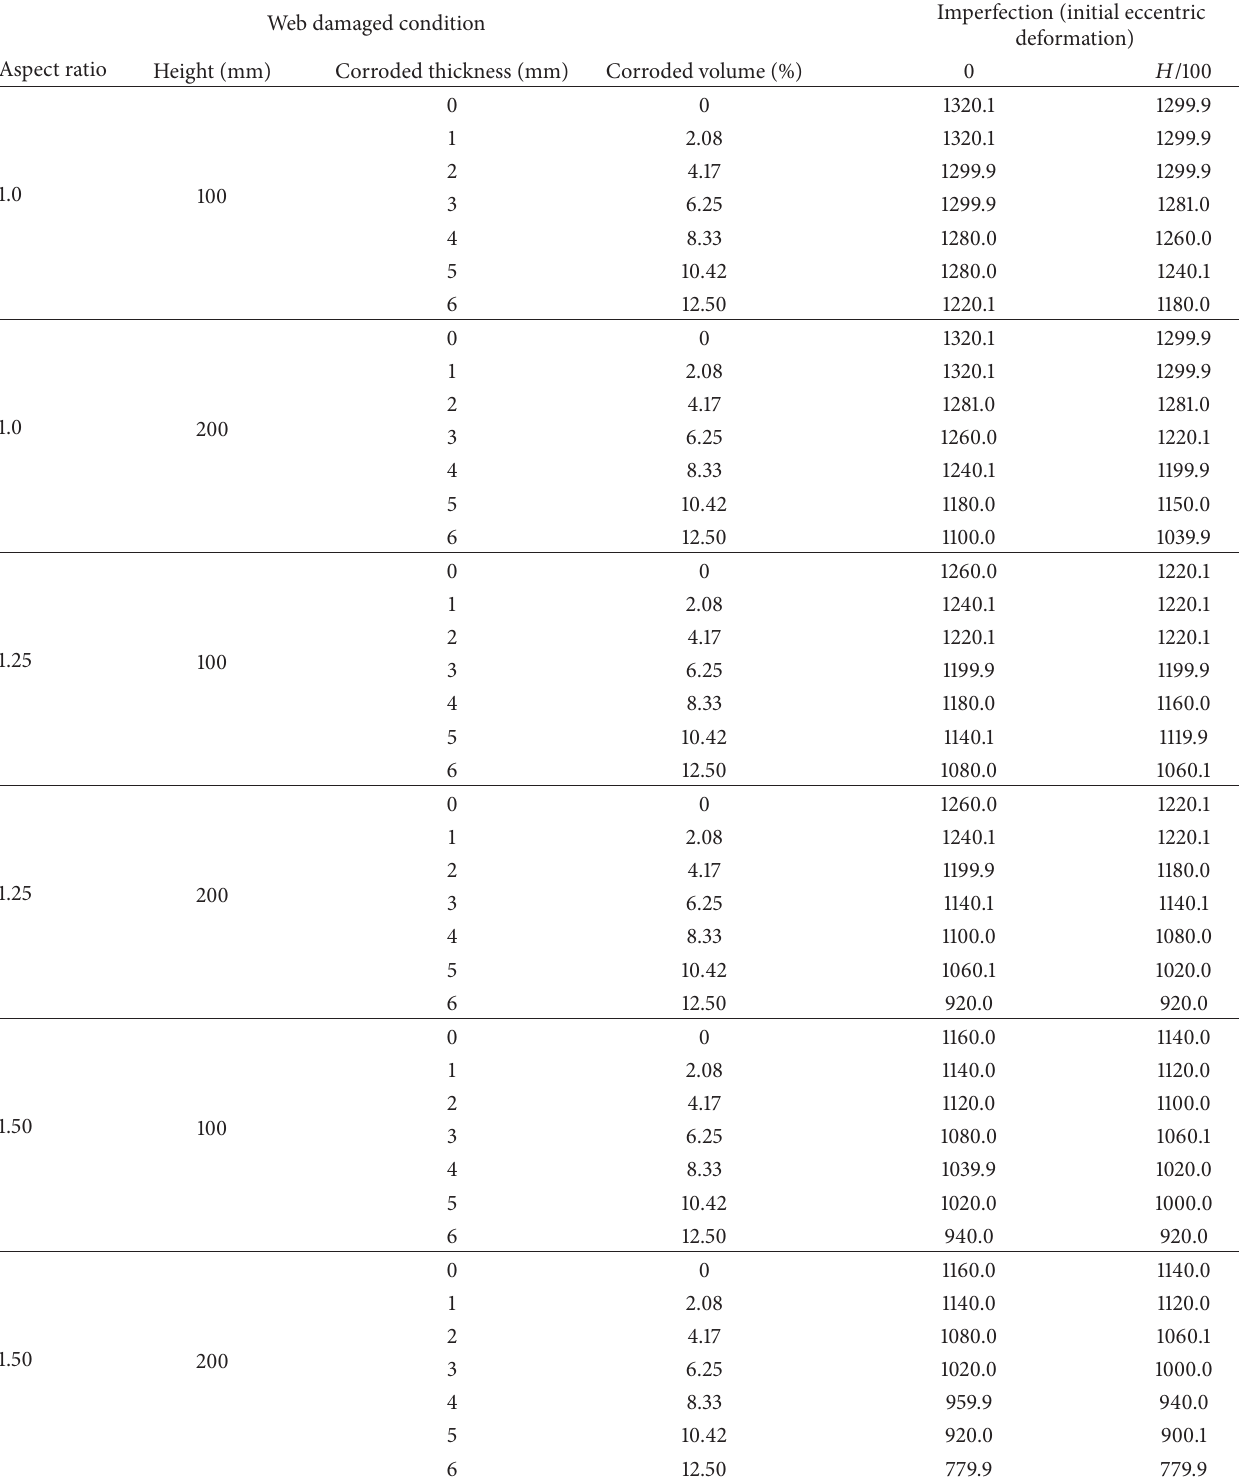
Table 5: Shear buckling resistance of a web plate with imperfection depending on aspect ratio